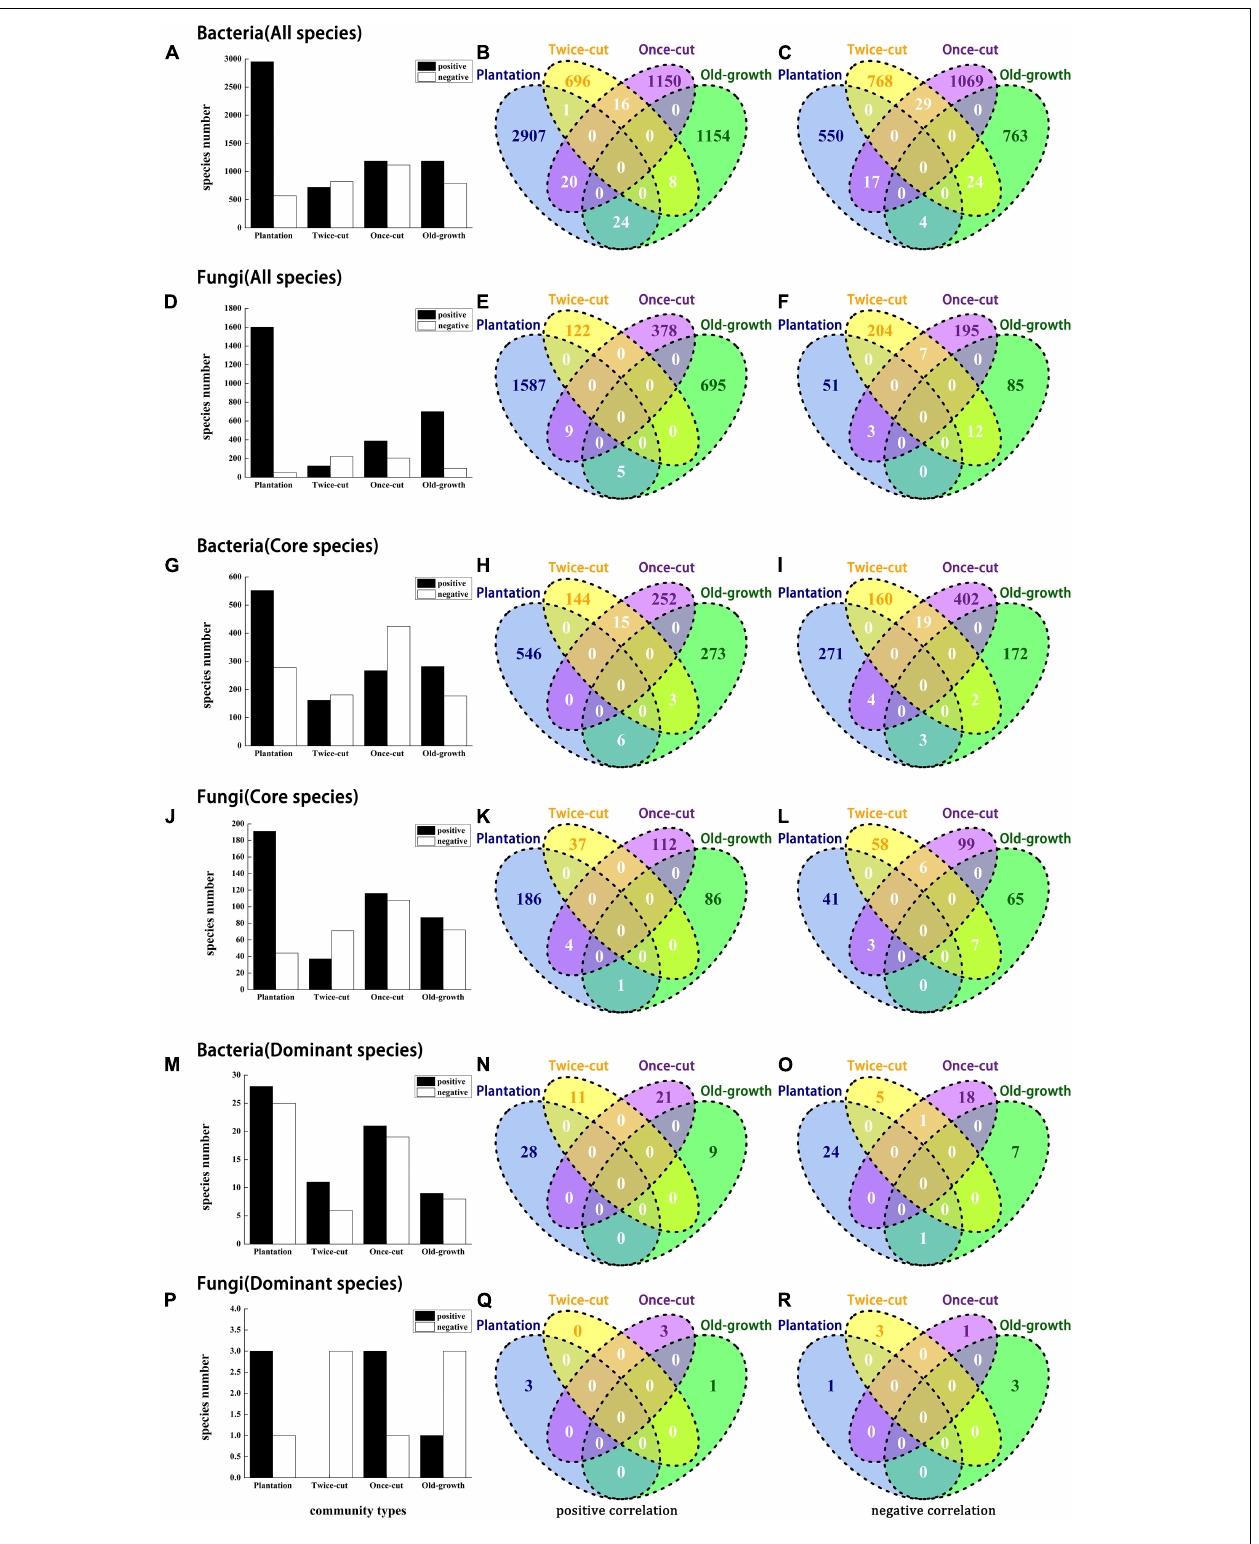
FIGURE 4 | Bars and Venn diagrams of bacterial and fungal distribution at the OTU level. The bar diagrams shows the number of bacteria and fungi associated with the four forest succession. Venn diagrams show the number of species with significant positive and negative correlations between bacteria and fungi in the four forest succession. The association between microbes and plant community was tested by torus-translation random test (Torus-translation test, P ≤ 0.05 significance level).